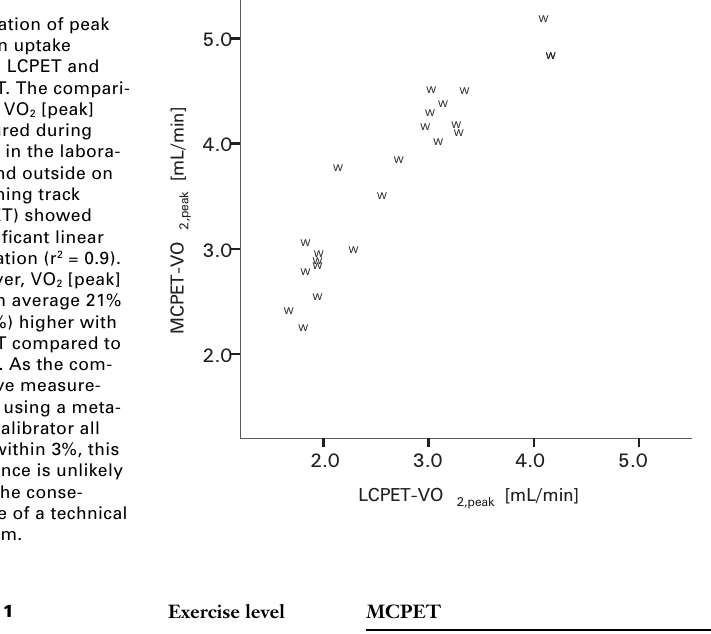
Table 1 Exercise parameters and subjective ratings of physical exhaustion.